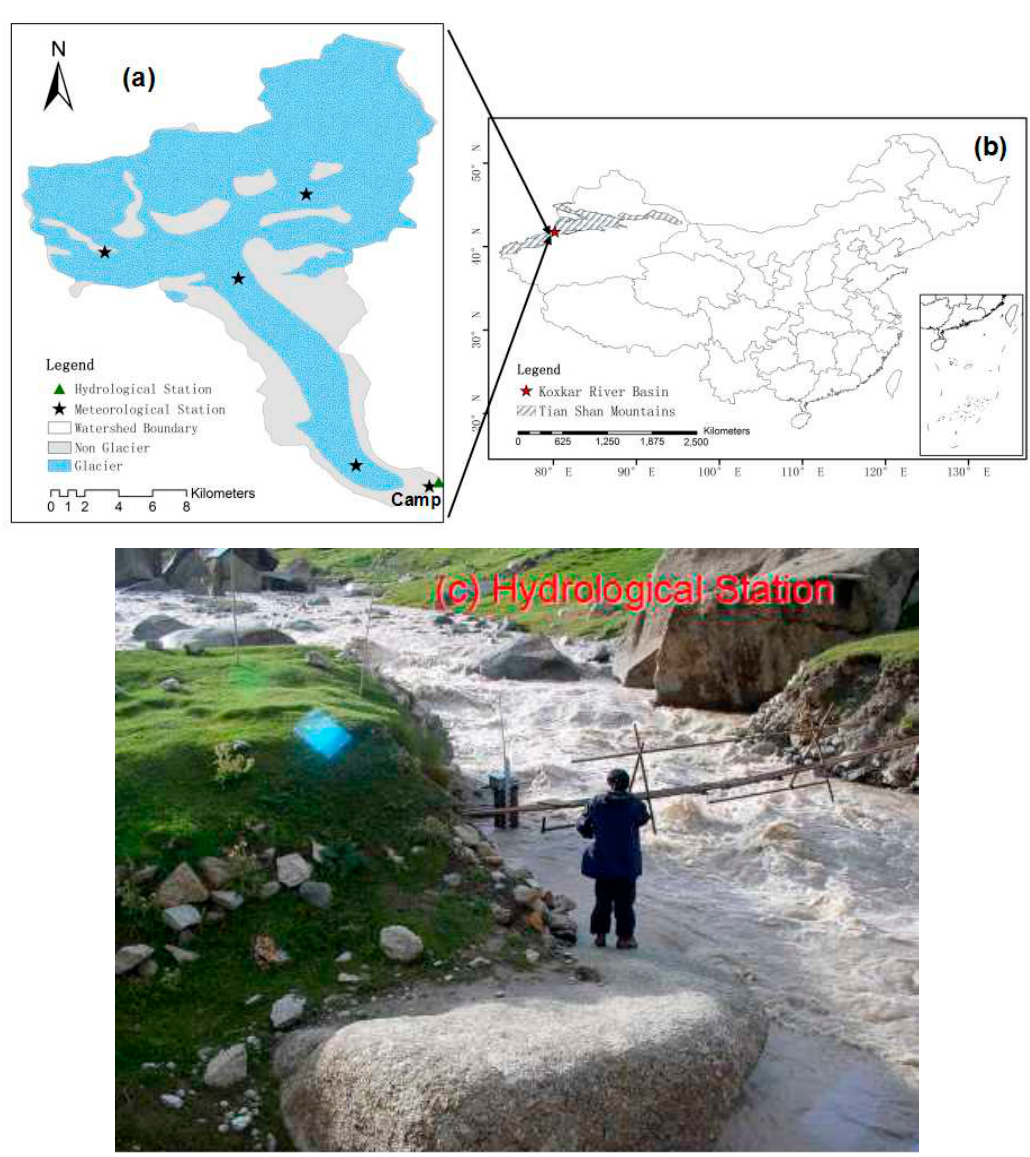
Figure 1. The locations of the Koxkar River Basin KRB ( a ), sites of observation (four meteorological stations around the KRB are shown at top right ( b ) and hydrological station ( c ).